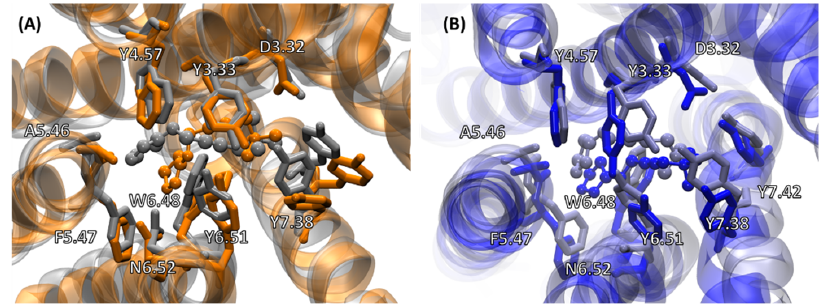
Figure 3. (A) Overlay of ligand binding sites in the M1:Gαq (orange) and M1:G11 (gray) structures; (B) Overlay of the M2:Gαi (blue) and M2:Go (blue-gray) structures. The receptor side chains are shown in licorice (solid bonds) representation, and the ligand is shown in ball-and-stick representation. The G proteins are not shown as they do not interact with the ligands.